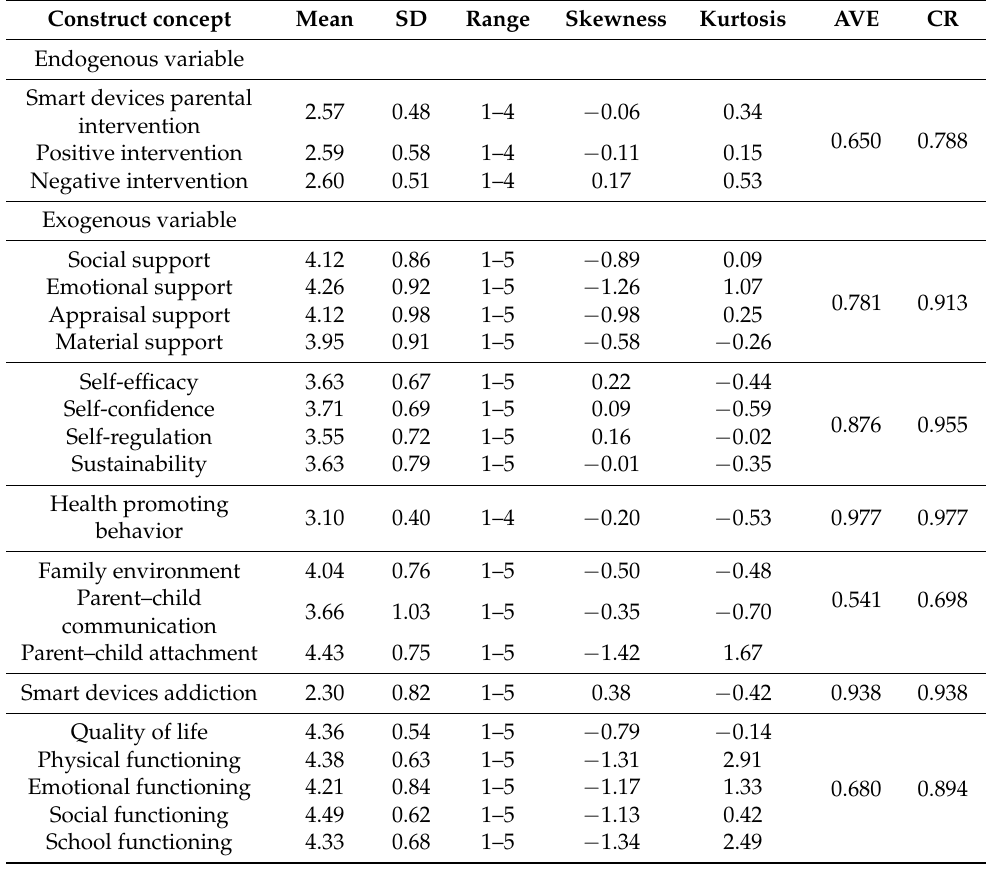
Table 2. Descriptive statistics and confirmatory factor analyses of measured